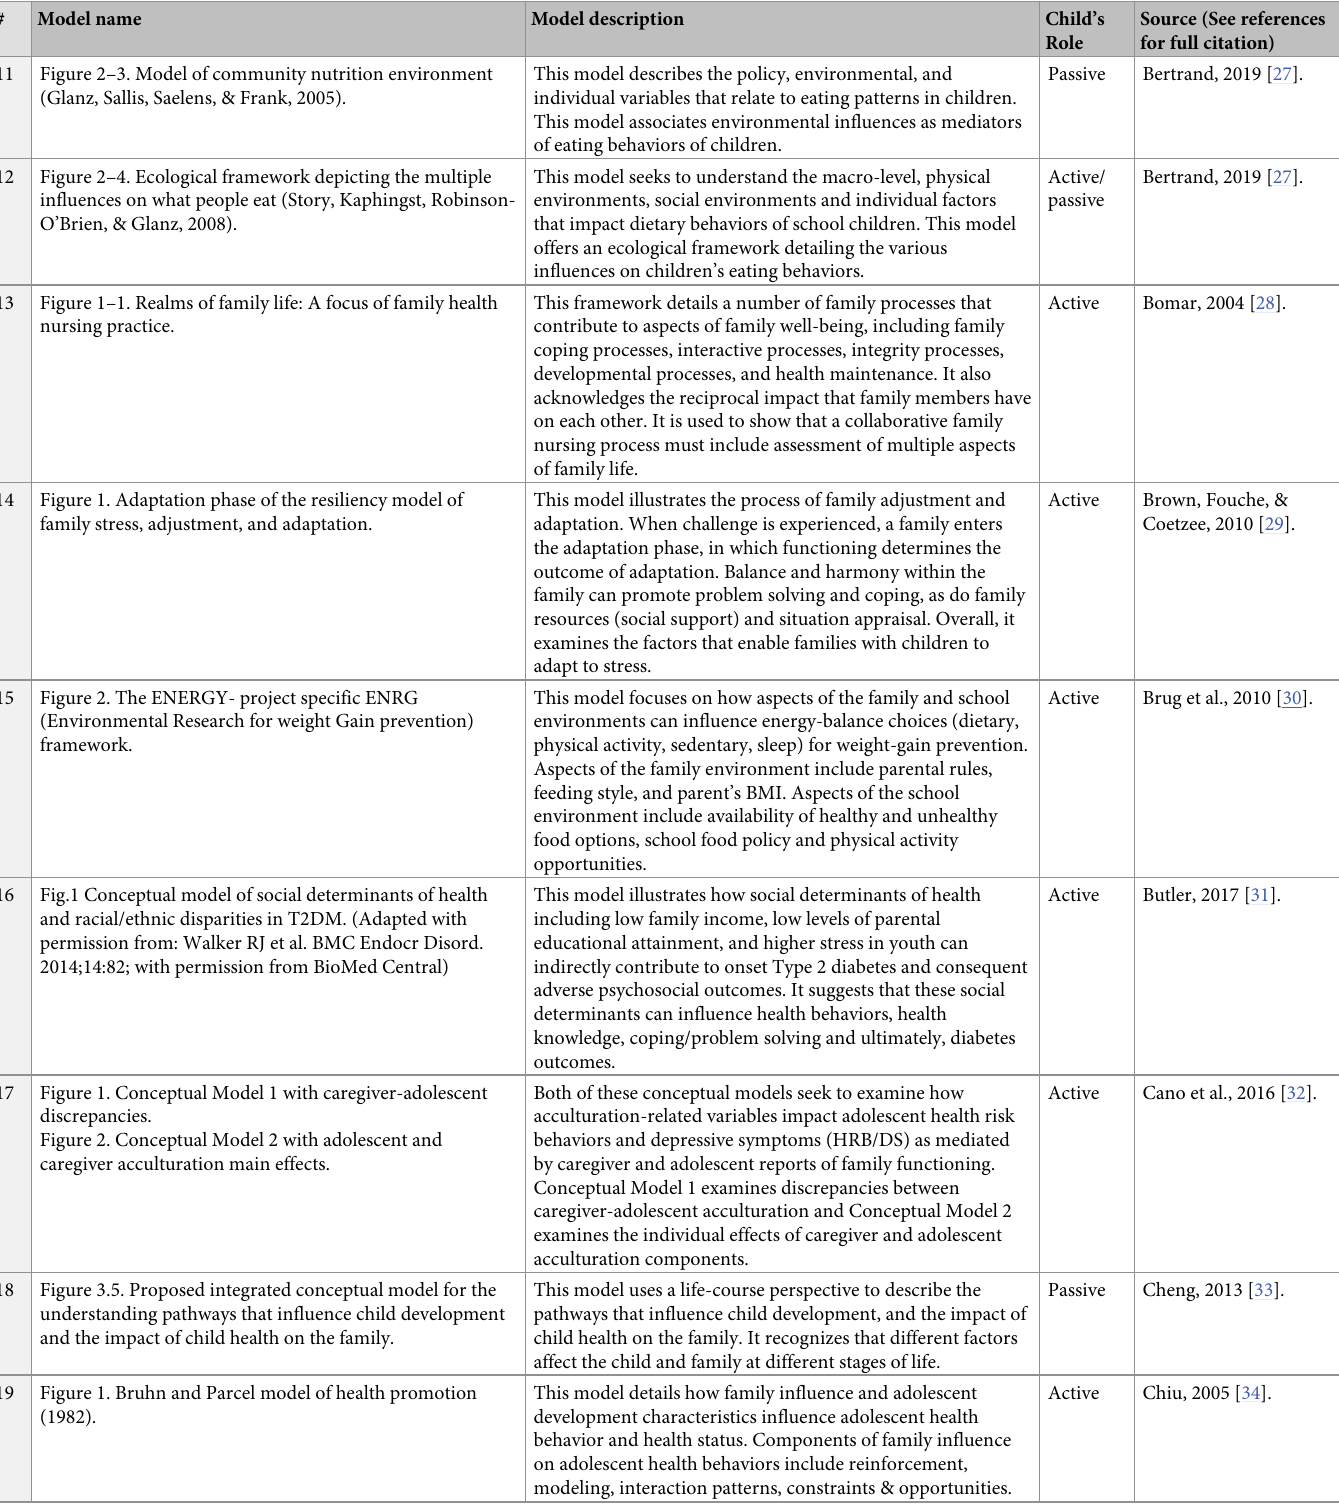
Figure 2–3. Model of community nutrition environment (Glanz, Sallis, Saelens, & Frank, 2005).